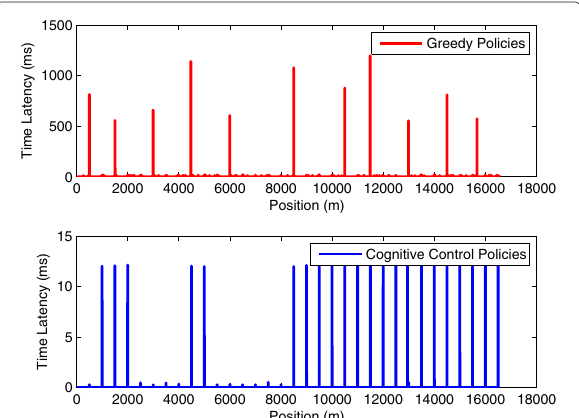
However, the application of MIMO can improve the trans- mission performance, and the appropriate handoff deci-